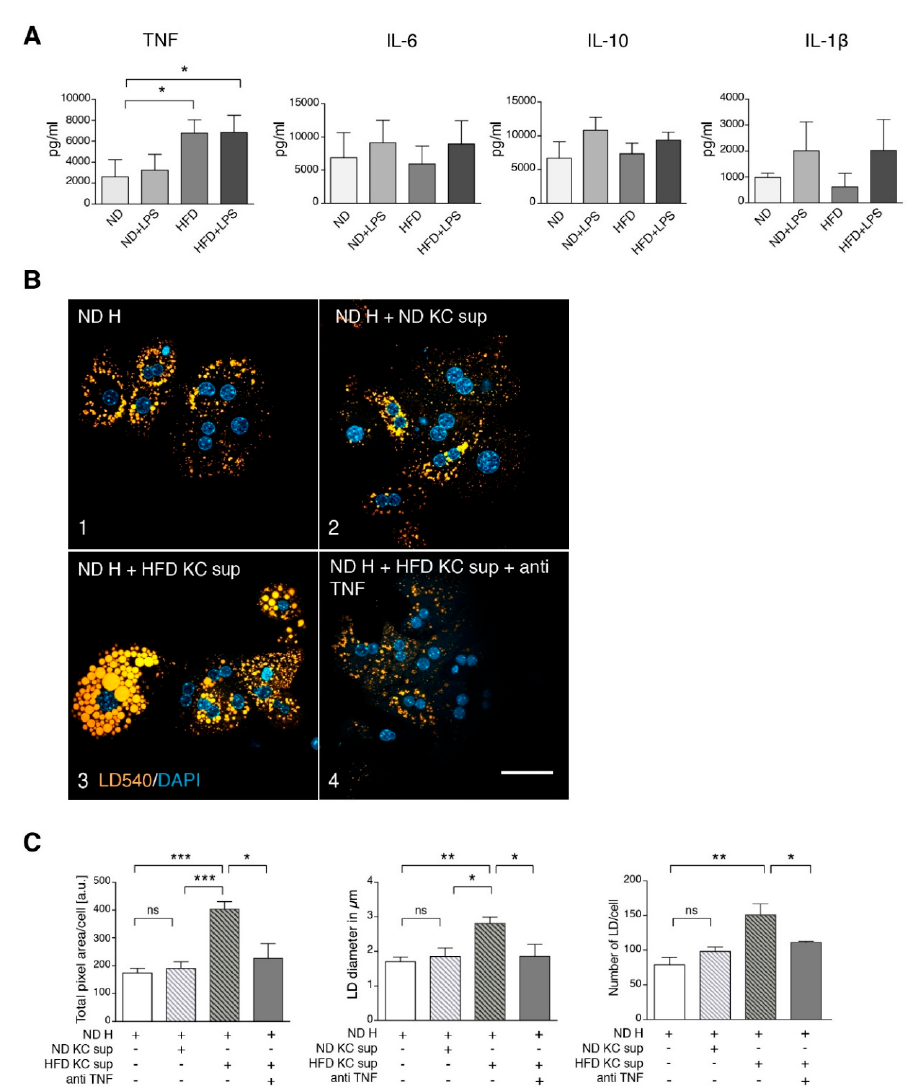
Figure 3. Kup ff er cell supernatant from HFD mice stimulates steatosis in ND hepatocytes via tumor necrosis factor (TNF). ( A ) Cytokine secretion by Kup ff er cells from untreated and LPS-treated ND and HFD mice. Mice were treated as indicated, Kup ff er cells were isolated and cultured for 16 h. Secreted cytokines were measured by ELISA (TNF n ≥ 3, IL-1 β n ≥ 3, IL-6 n ≥ 4, IL-10 n ≥ 2). ( B ) Freshly isolated hepatocytes (H) from ND mice were cultured in the absence (frame 1) or presence of 16 h pre-conditioned supernatant of Kup ff er cells (KC sup) from ND (frame 2) or HFD mice (frame 3 and 4) as indicated. In frame 4, a neutralizing TNF antibody was added. Microscopy images of cells that were stained for lipid droplets (LD540) and nuclei (DAPI) are shown. Scale bar: 50 µ m. ( C ) Quantification of the total fluorescent LD area / cell, average LD diameter in µ m and LD number / cell of the various conditions ( n ≥ 3). Mean values with SEM of at least three independent experiments are